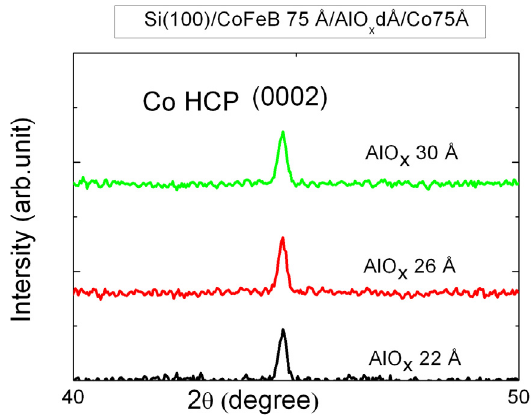
Figure 1. X-ray diffraction patterns of CoFeB(75 Å)/AlO tunneling junction (MTJ).